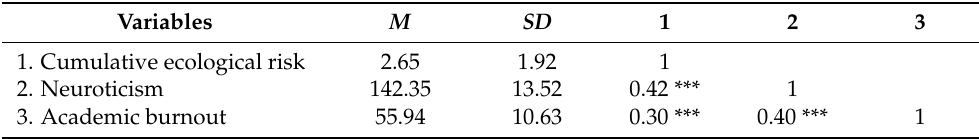
Table 2. Correlations of the main study variables ( N = 580).